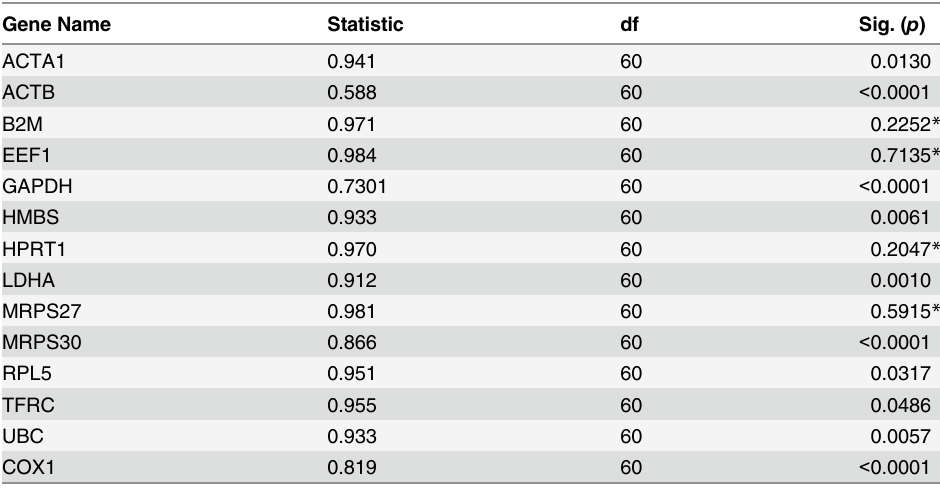
Table 3. Normality test (Shapiro-Wilk).